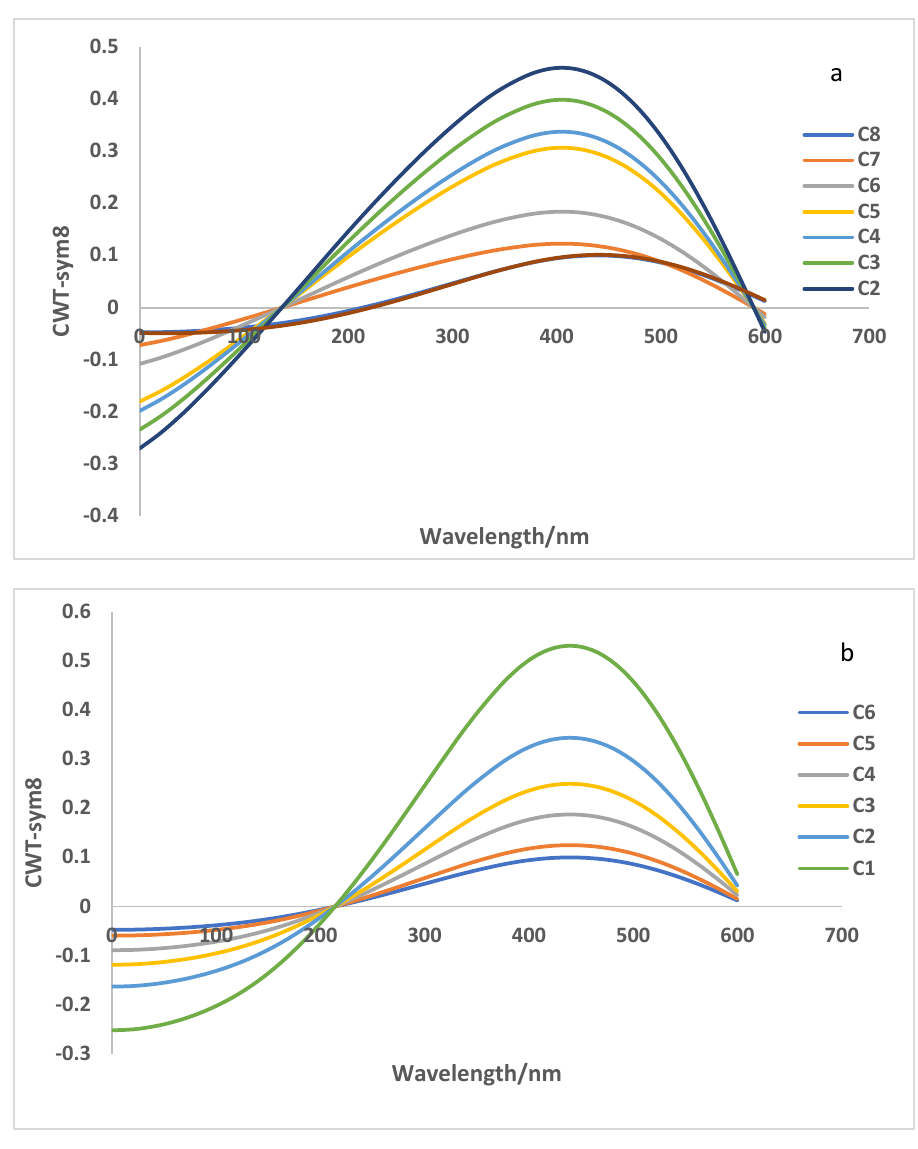
Figure 4. ( a ) Transformed kinetic profiles of ( a ) UA 5 (C1), 10 (C2), 20 (C3), 30(C4), 35 (C5), 40 (C6), 50 (C7) and 55 (C8) μ mol L − 1 and ( b ) DA 7 (C1), 10 (C2), 15 (C3), 20 (C4), 30 (C5), and 40 (C6) μ mol L − 1 . using sym8.